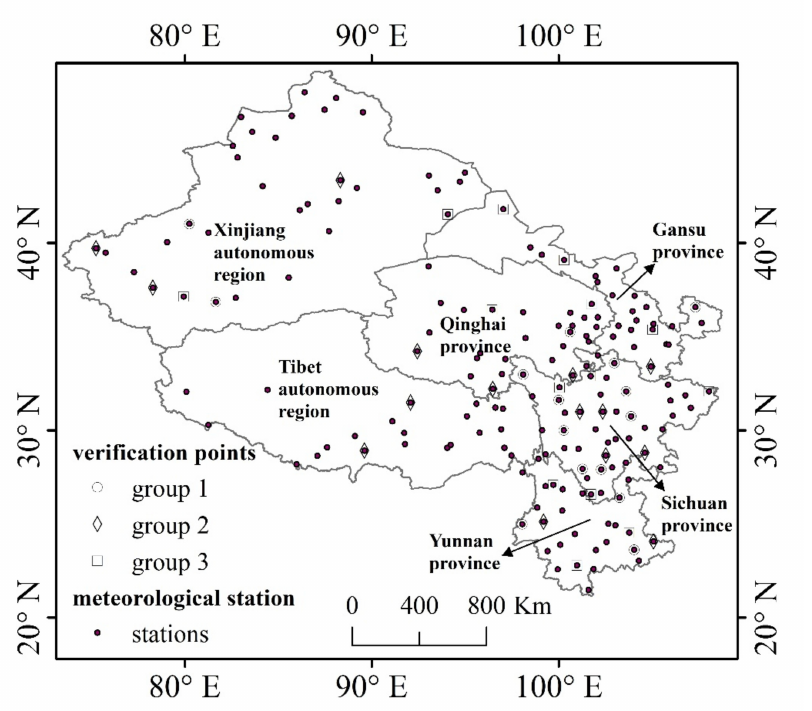
Figure 2. The distribution of meteorological stations and the selection of verification points (groups